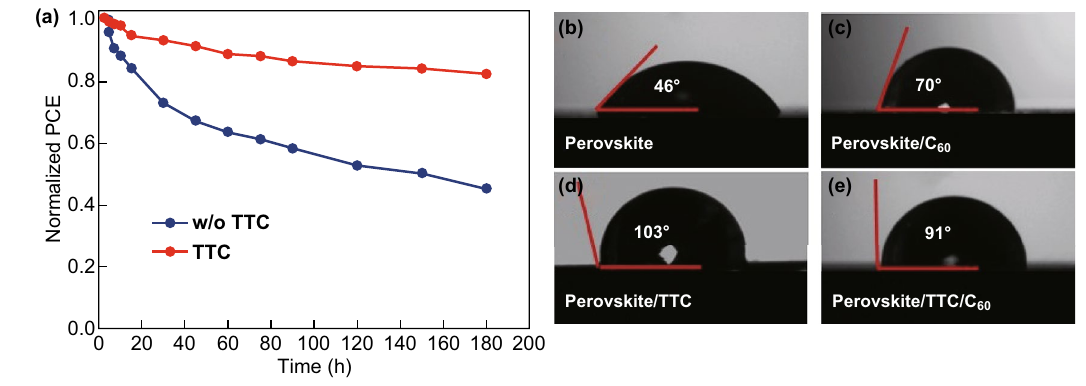
Fig. 4 a Device stability of control and TTC-based PVSCs. The contact angles of different films: b perovskite, c perovskite/C 60 , d perovskite/ TTC, and e